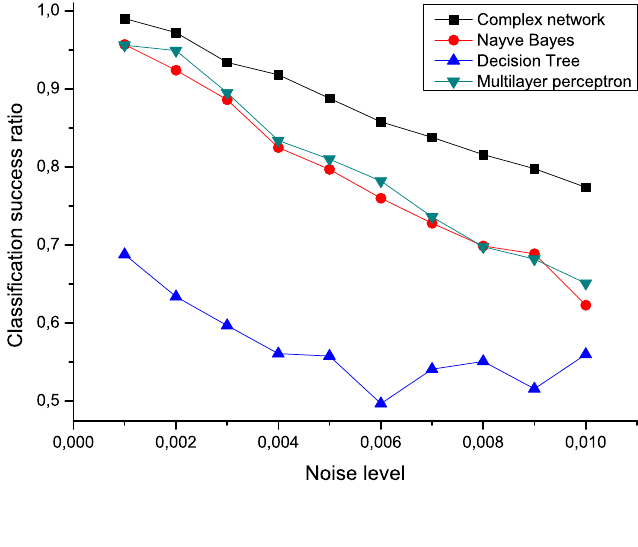
Figure 5. Mean classification scores obtained by four algorithms for data sets polluted with additive noise; the proposed network-based representation is represented by black